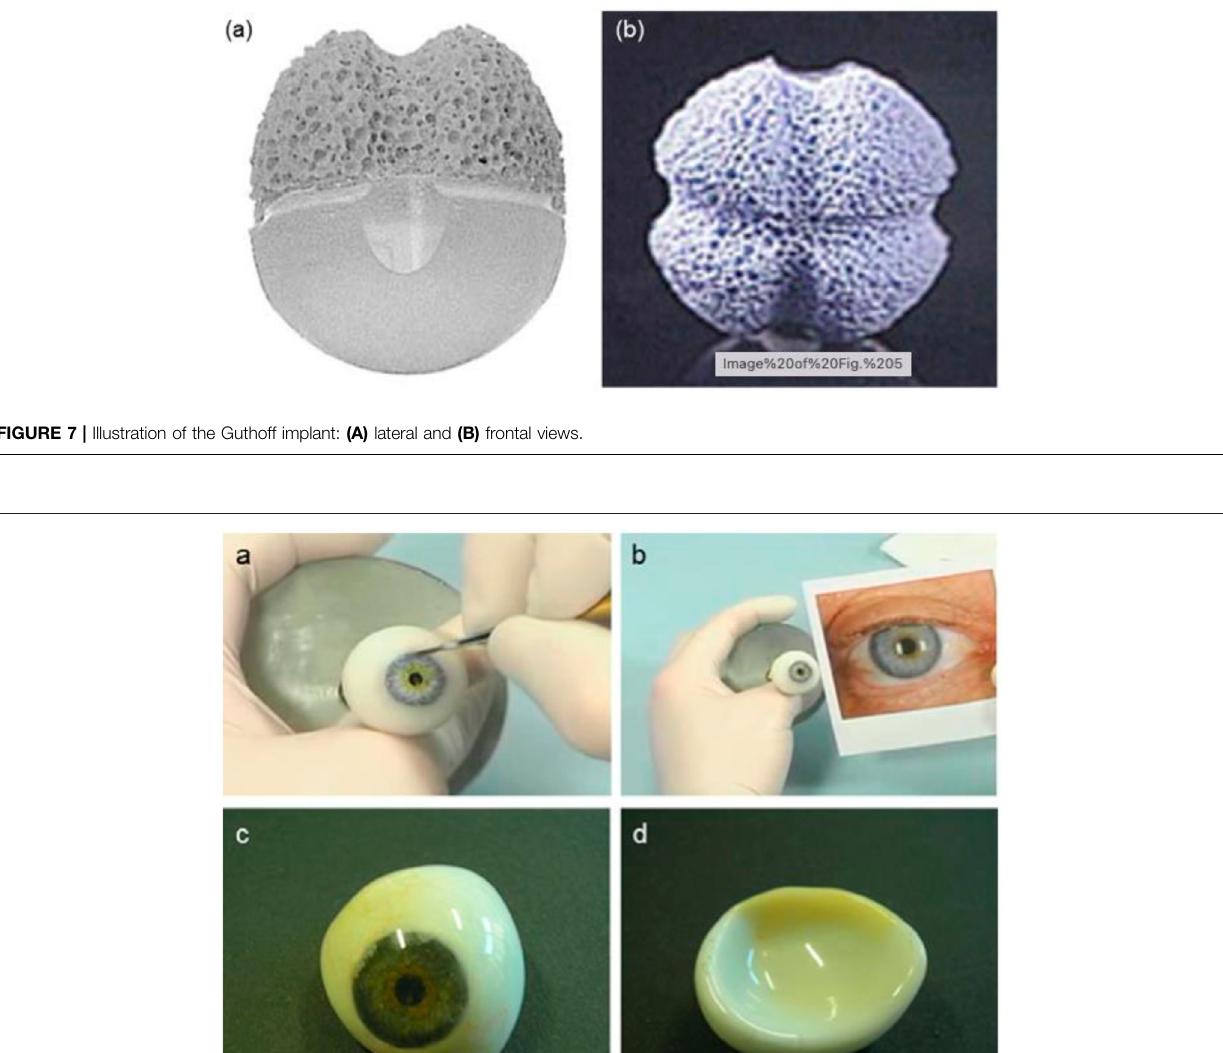
Frontiers in Bioengineering and Biotechnology |